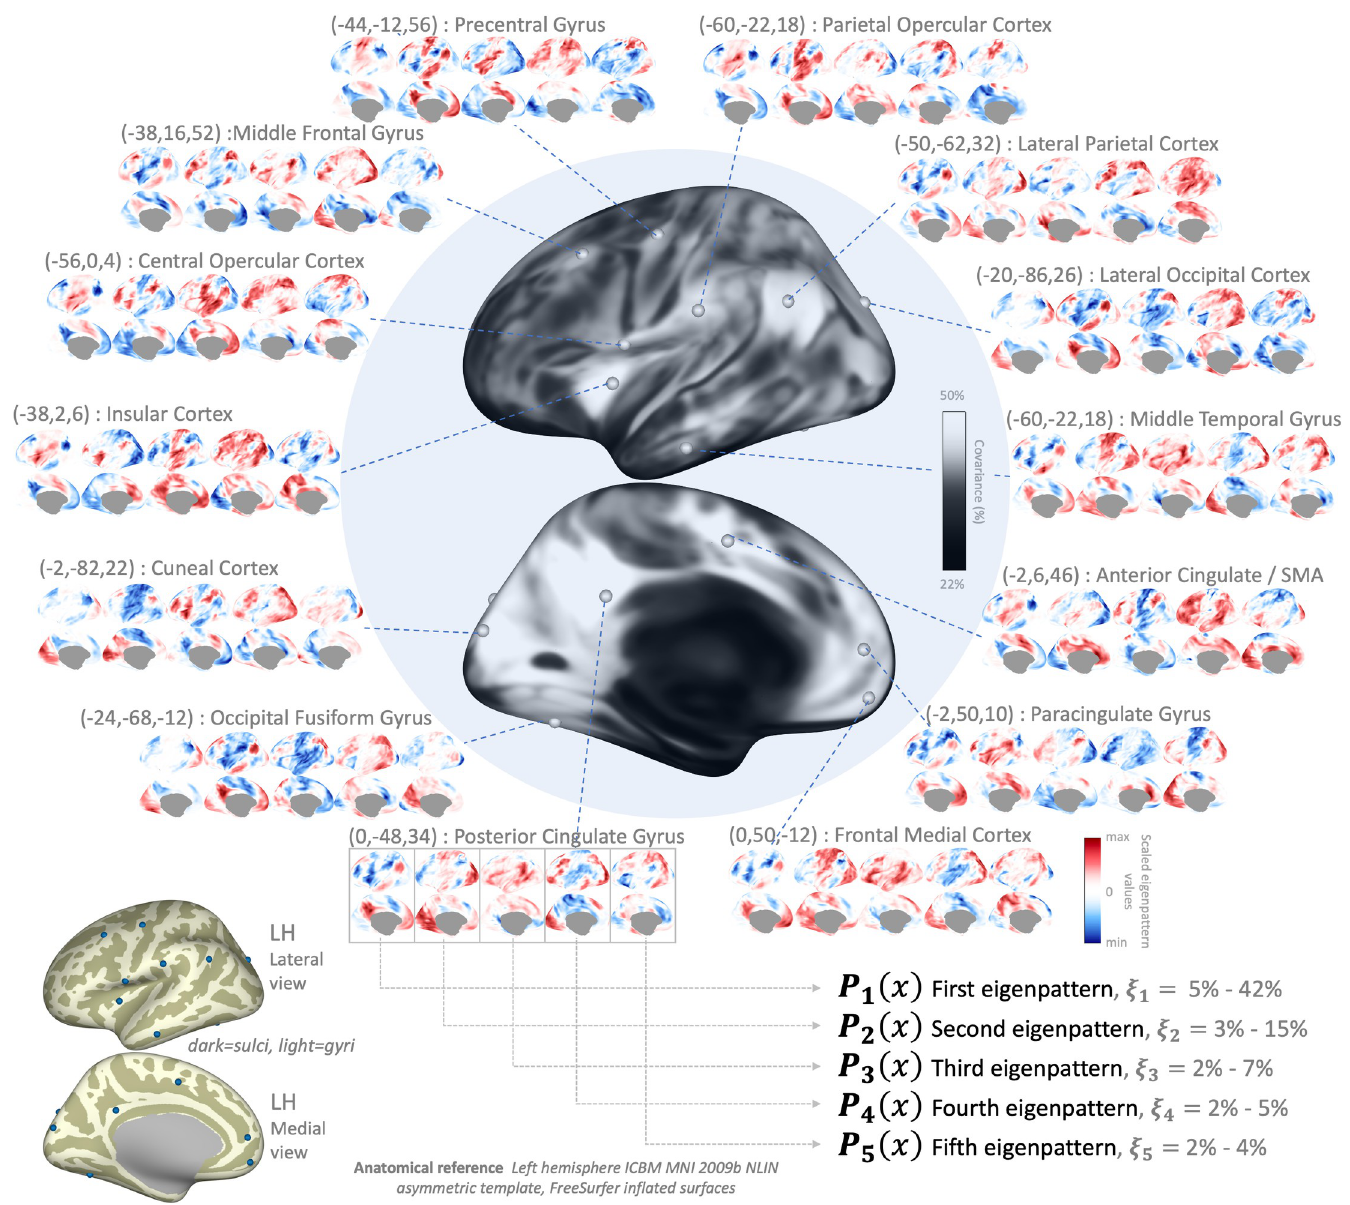
Fig 5. First 5 fc-MVPA eigenpatterns, characterizing the principal components of the local intersubject heterogeneity in functional connectivity maps. The central display shows the cumulative total covariance in functional connectivity patterns explained by the first 5 eigenpatterns at each voxel (colormap values range between 22%/black to 50%/white). The first five eigenpatterns at 14 manually-defined example locations are shown in a circular display. In each of these plots, eigenpatterns range from first/left to fifth/right, and each eigenpattern is shown projected to a left hemisphere lateral (top plot) and medial (bottom plot) views, on a relative color scale ranging from blue (highest negative values for each eigenpattern) to yellow (highest positive values).